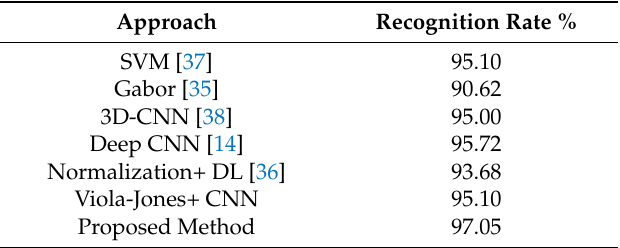
The comparison between different approaches and our approach for the CK+ face database.CNN— convolutional neural network.